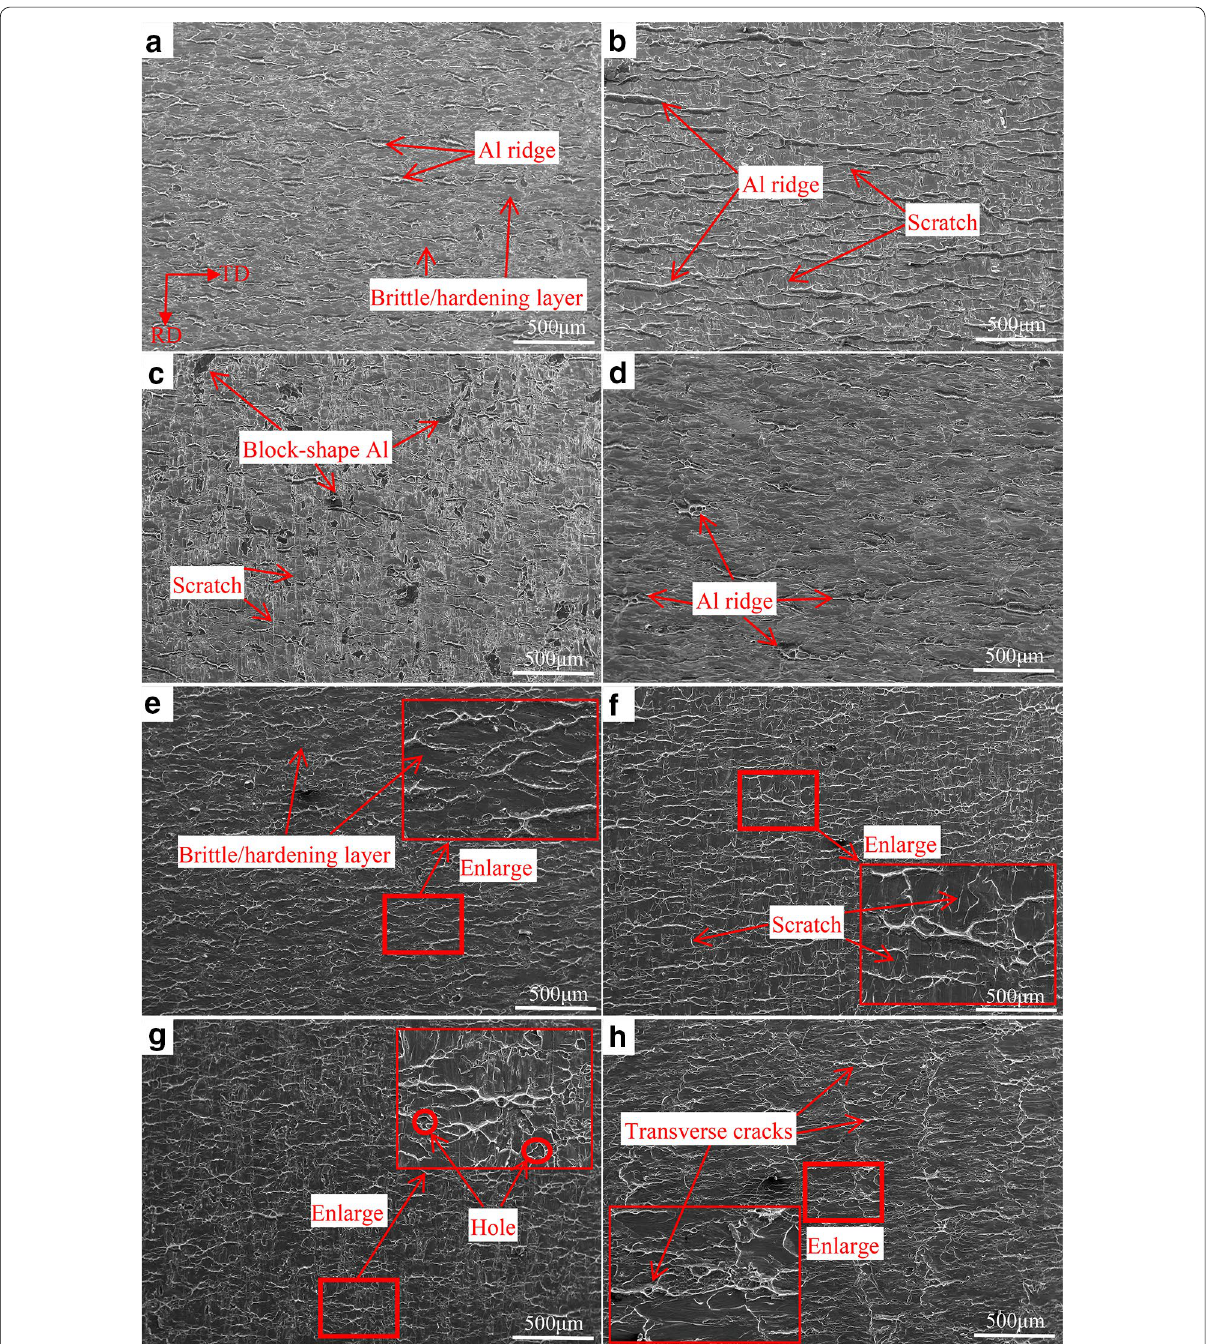
Fig. 8 Fracture morphology of peeling samples: a VRDG/Cu side; b PRDG/Cu side; c 90° CG/Cu side; d RWBG/Cu side; e VRDG/Al side; f PRDG/Al side; g 90° CG/Al side; h RWBG/Al